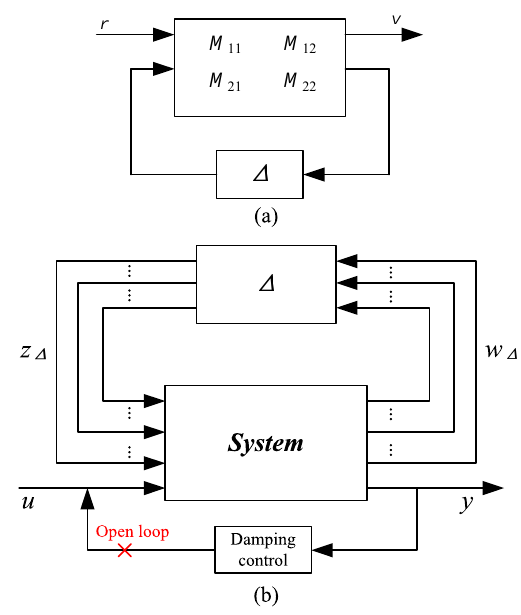
Figure 6. ( a ) Framework for robust stability analysis; ( b ) the uncertain model for power